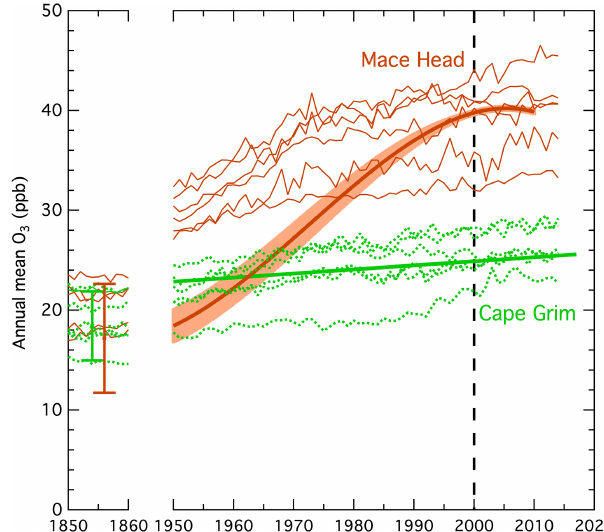
Figure 4. Comparison of modeled and measured long-term changes in annual mean ozone mixing ratios at Mace Head and Cape Grim from 1850–1860 (left) and after 1950 (right). The fits to the mea- surements (heavy solid line and curve on the right) are the same as those in Fig. 3. The thinner solid (for Mace Head) and dotted (for Cape Grim) curves are results from six ESMs that participated in the CMIP6 exercise. The two symbols on the left show the range of annual mean pre-industrial midlatitude (30 ◦ to 60 ◦ ) surface ozone calculated by the STOCHEM-CRI model for the five simulations discussed in the